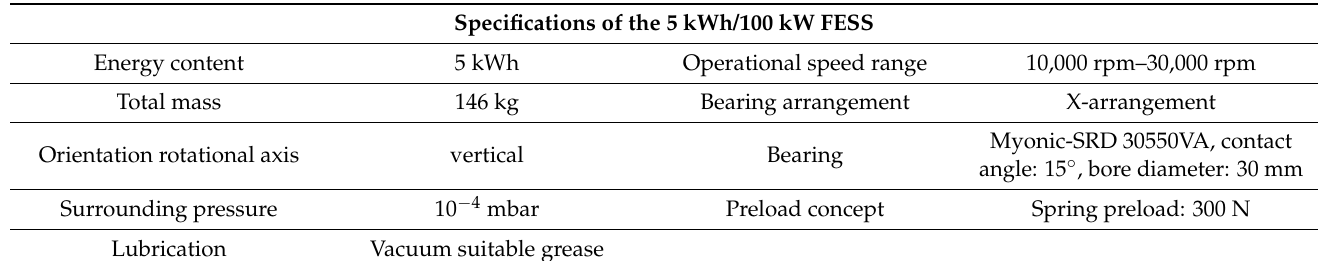
Table 9. Main Characteristics of the described